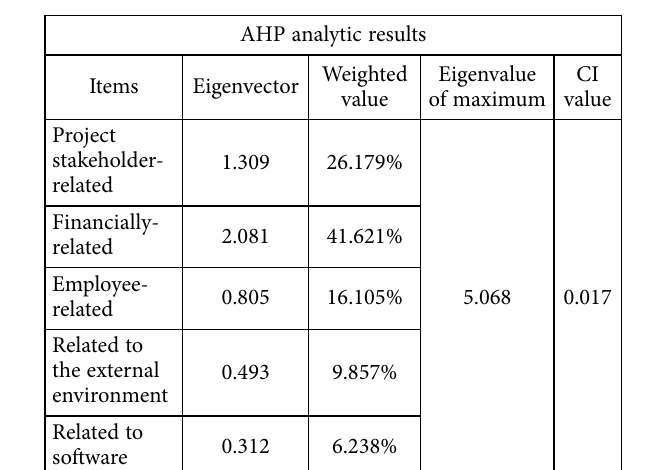
Table 10. AHP analytic